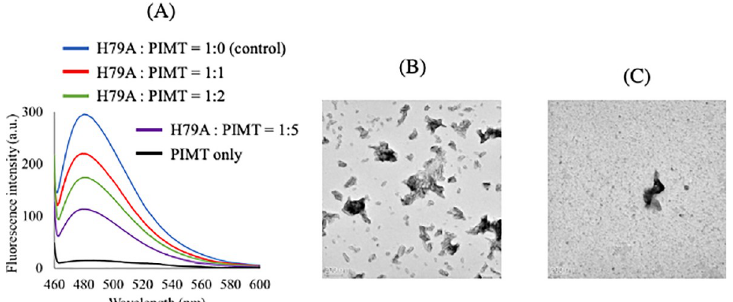
Fig 6. PIMT decreased the formation of amyloid-like fibrils of H79A alanine substituent of α A66–80 peptides. (A) Repair activity of PIMT was monitored as the intensity of ThT fluorescence. The mass ratio of H79A to PIMT was 1:0 (blue), 1:1 (red), 1:2 (green), and 1:5 (purple). Black lines show the emission spectrum of the ThT solution in the absence of peptide. Each spectrum represents an average of five scans. (B) TEM images of negatively stained fibrils of L-isoAsp containing H79A α A66–80 after heat incubation in the absence of PIMT. (C) TEM images of negatively stained fibrils of L-isoAsp containing H79A α A66–80 after heat incubation in the presence of PIMT.